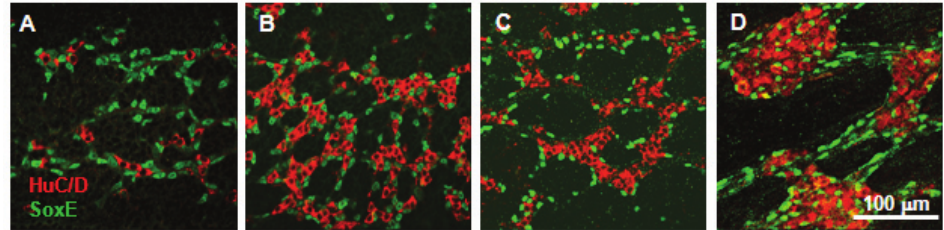
Figure 2. Gradual aggregation of ENS cells form ganglia in the embryonic quail midgut. A . QE5 midgut with chains of SoxE +ve ENC cells and a smaller number of scattered Hu +ve neurons. B . QE6 midgut with relatively more neurons in small groups, with adjacent ENC cells. C . QE8 midgut with coherent ENS neuron groups surrounded by SoxE +ve cells. D . QE14 midgut with large ENS ganglia with SoxE +ve cells both around the ganglia and in the ganglia mixed with the neurons, and also distributed along interganglionic tracts. Images are single confocal optical sections through the myenteric